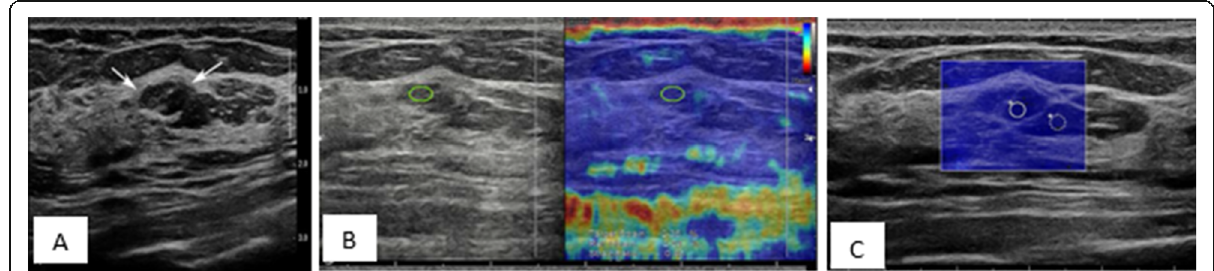
Fig. 12 An abnormality detected via screening mammography in a 51-year-old woman ( a ). Grayscale ultrasound shows an indistinct oval heterogeneous echoic mass (arrows) ( b ). SE revealed intra-region heterogeneity with malignancy elasticity index and c SWE obtained two regions with malignant elasticity